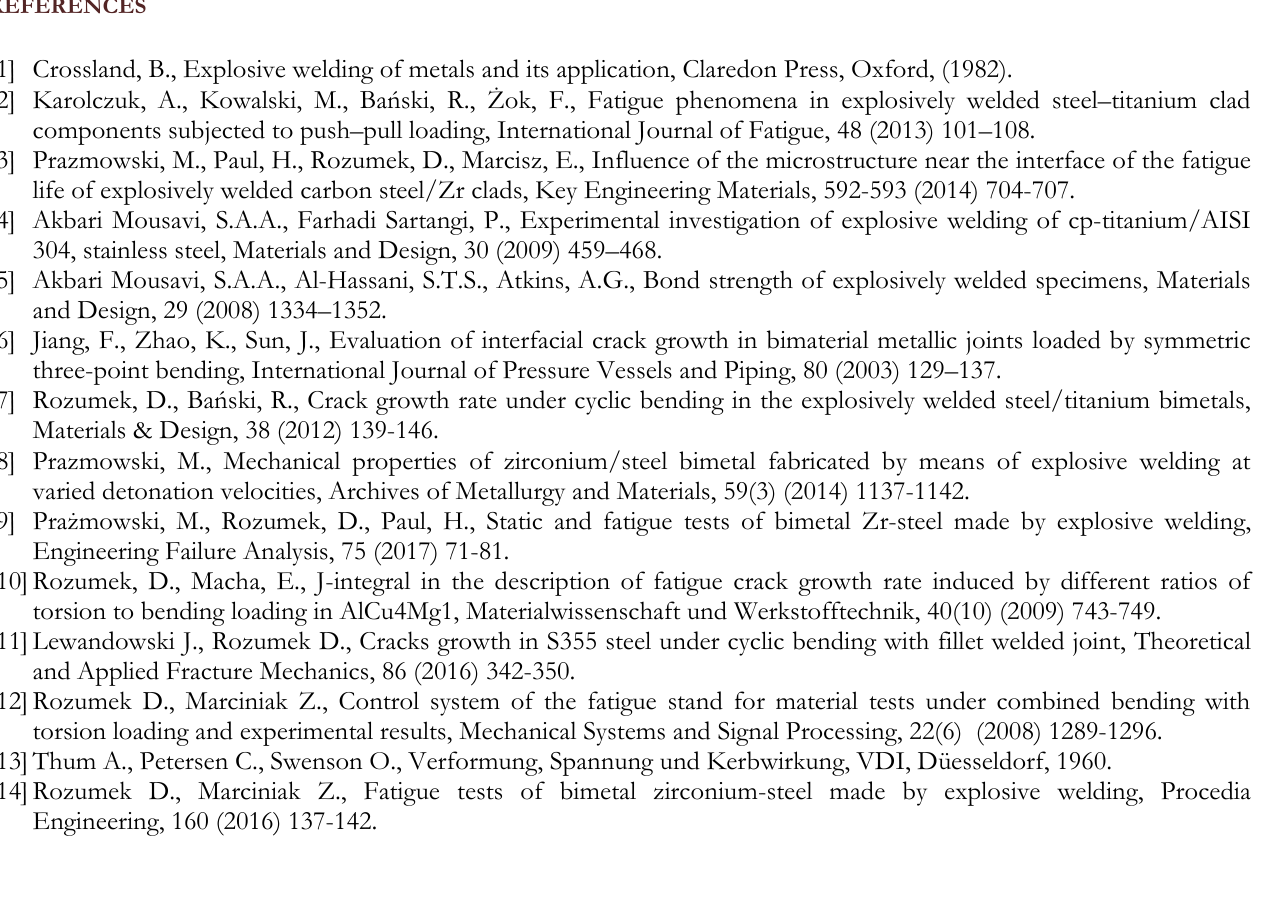
Two different interaction mechanisms between a crack and interface were